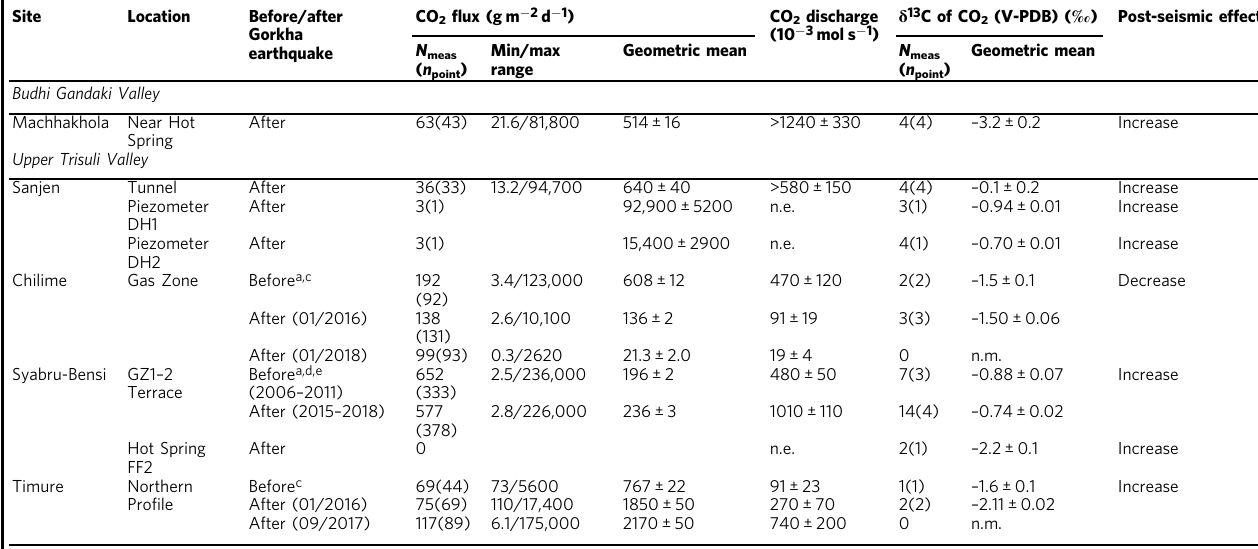
Table 1 Post-seismic effects on the carbon dioxide emissions at fi ve hydrothermal sites in Central Nepal. Data of CO 2 fl ux, total CO 2 discharge, and carbon isotopic ratio of CO 2 emissions are compiled before and after the Gorkha